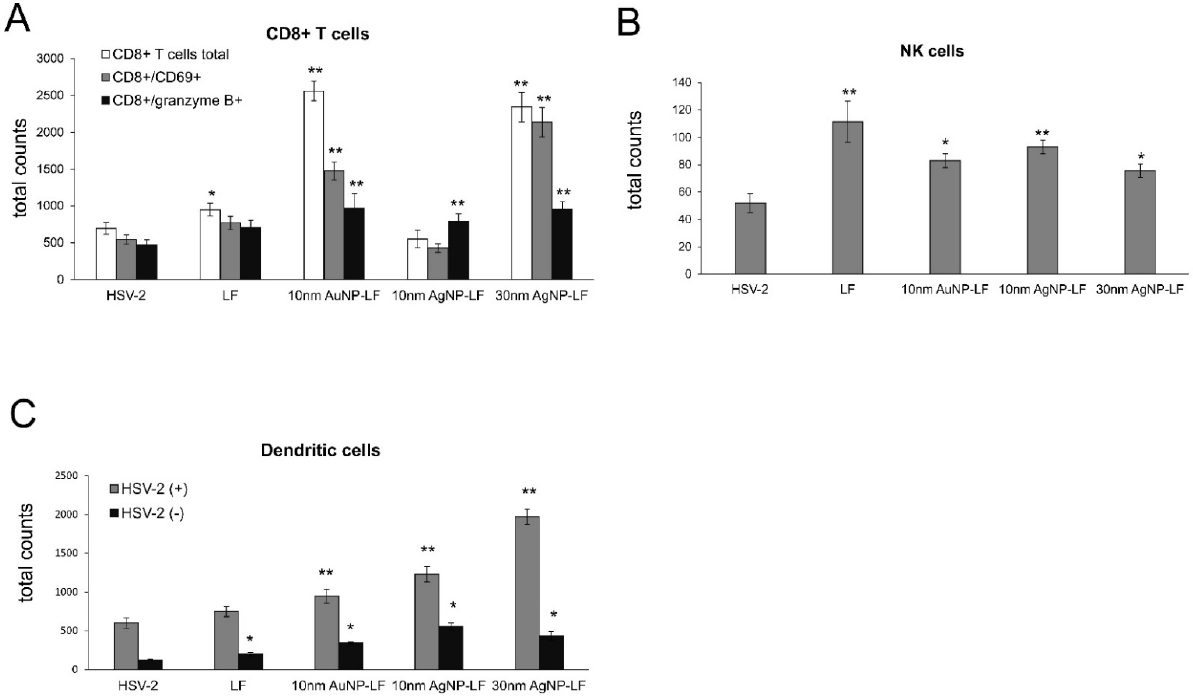
Figure 6. Lactoferrin-modified Ag/AuNPs activate early antiviral response in HSV-2 vaginal infection. Total counts of ( A ) CD8+ T cells, CD8+CD69+ T cells, CD8+/granzymeB+ T cells, ( B ) NK cells, and ( C ) dendritic cells in the vaginal tissue treated with NaCl or 10 nm LF-Ag/AuNPs, 30 nm LF-AgNPs or lactoferrin at 24, 48 and 72 h p.i. and isolated for further assays at 7 day p.i. Results are expressed as mean +/ − SEM for N = 7. * represents significant differences with p ≤ 0.05, ** p ≤ 0.01 in comparison to untreated HSV-2 tissues (Student t test).